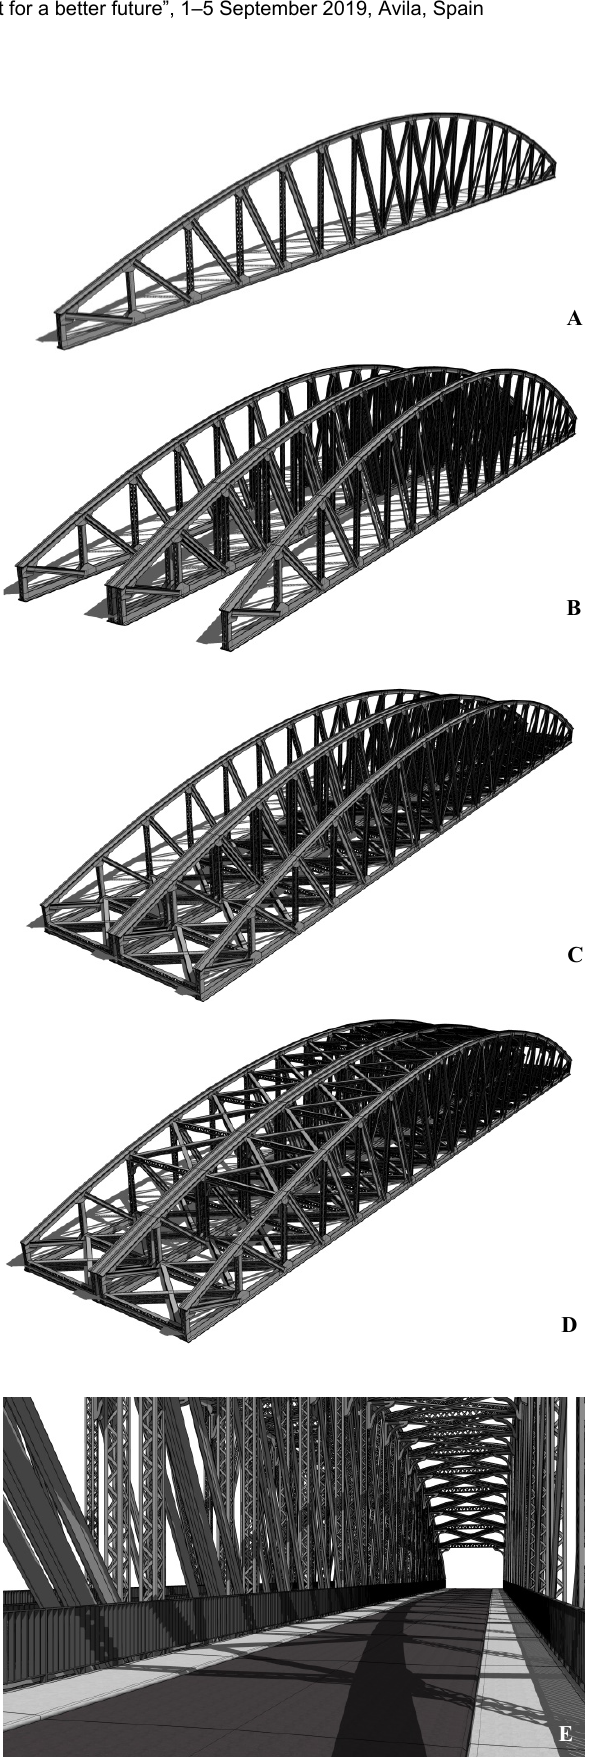
Figure 13. Steps and details of the modeling procedure of Alari